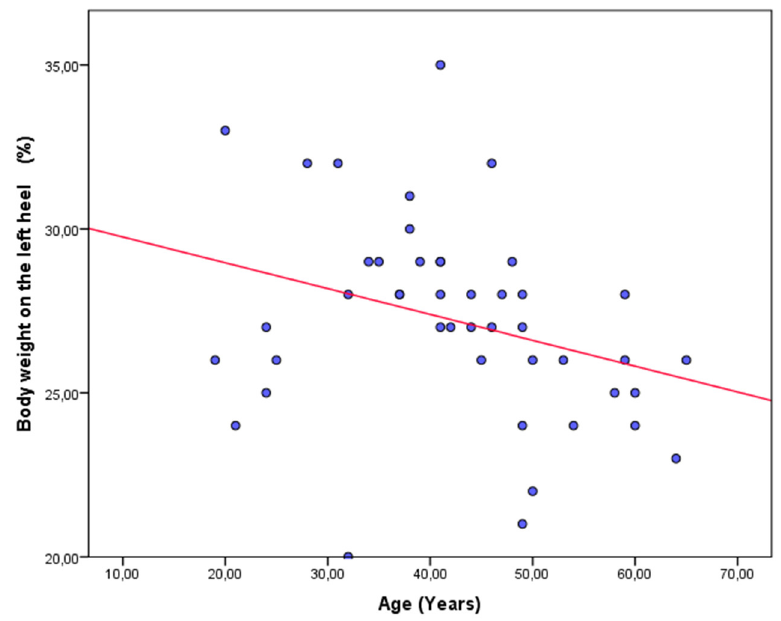
Figure 5. Scatter plot showing a significant negative moderate correlation between the body weight on the left heel and age in healthy participants.